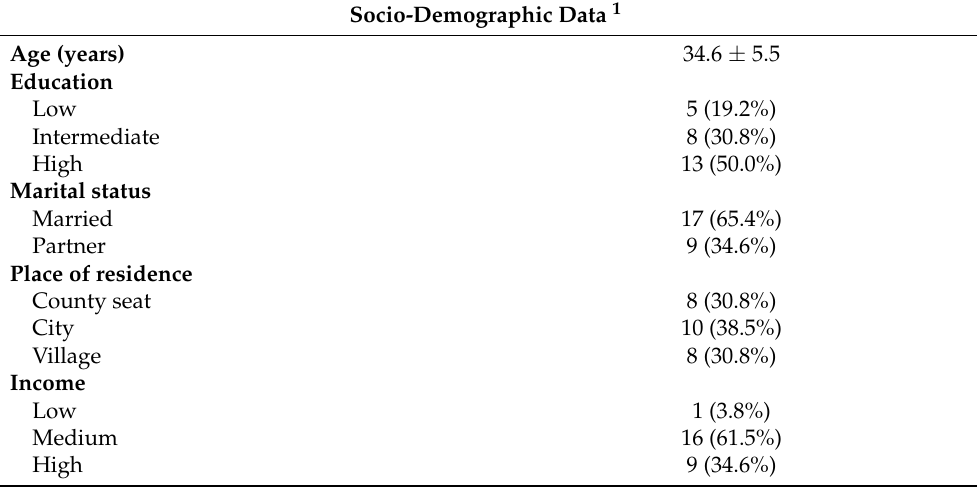
Table 1. Socio-demographic, health status, and lifestyle characteristics of the patients studied (N = 26).